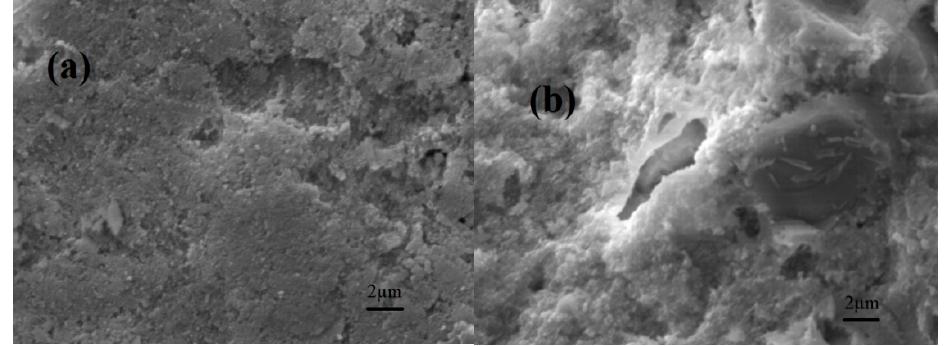
Figure 5. The external ( a ) and cross-sectional ( b ) surface SEM images of the 8YSZ-20% glass (700 °C) composite electrolyte.